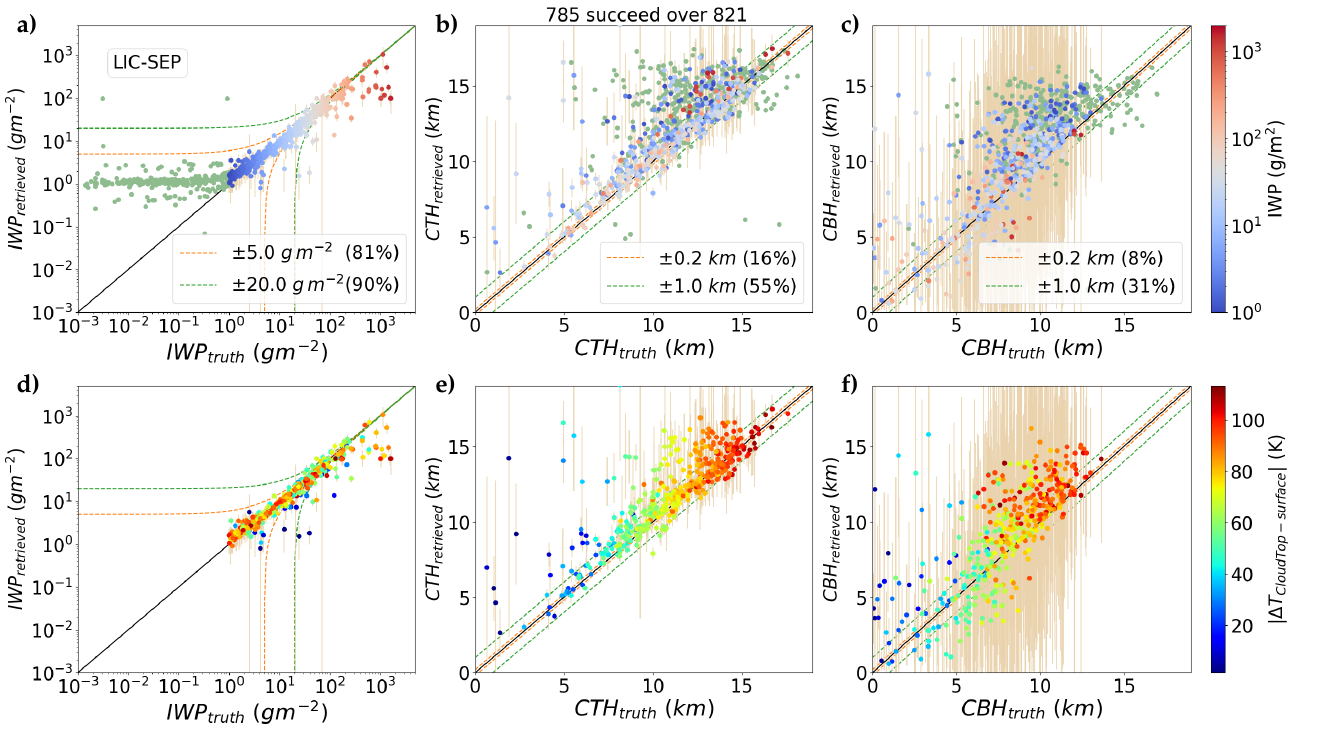
Figure 8. Same as Figure 7 but for LIC-SEP cloud configuration.